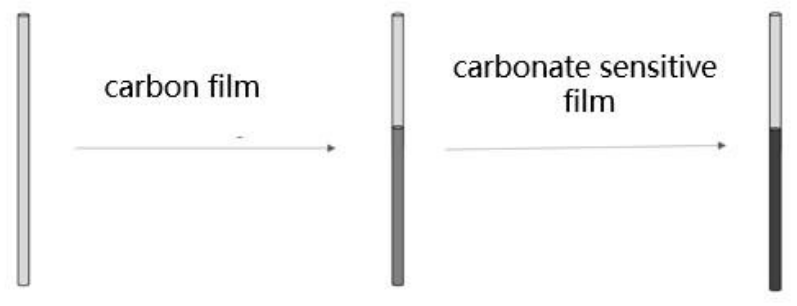
Figure 1. Diagram of the electrode preparation process.